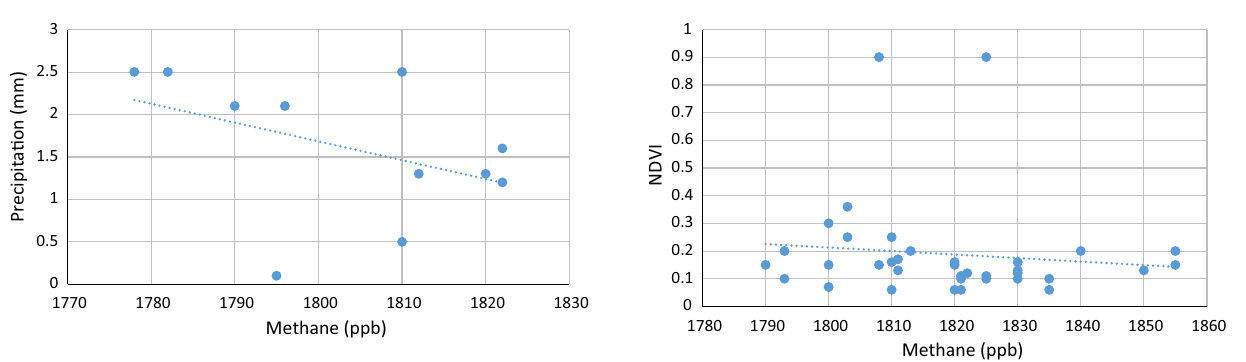
Fig. 8 Relationship between methane and NDVI in